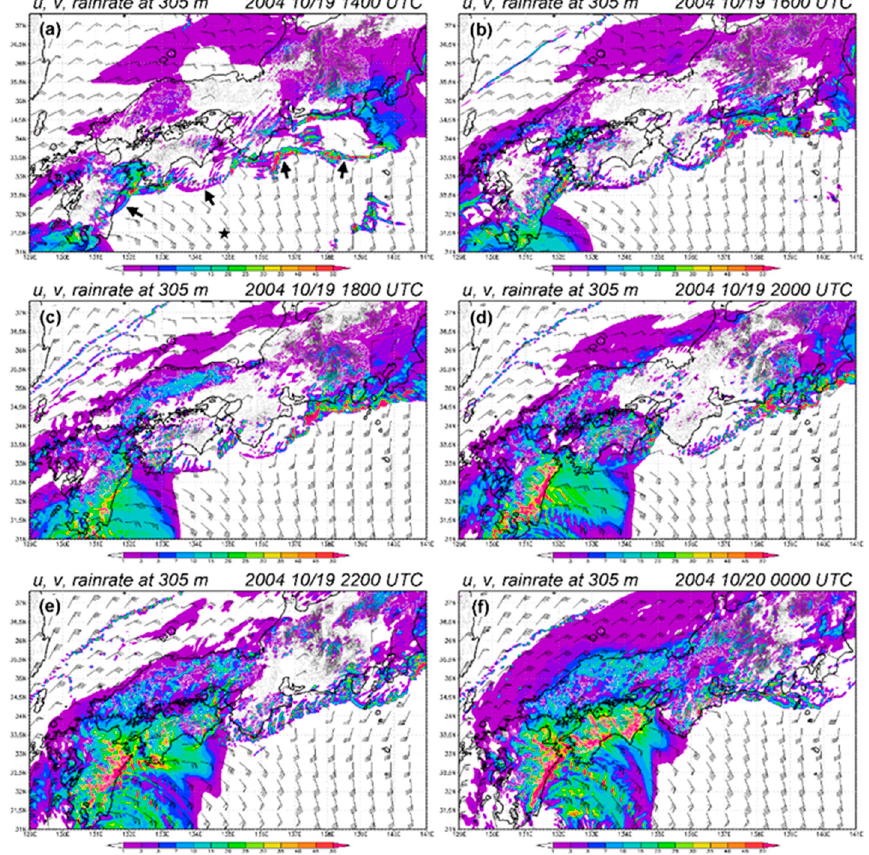
Figure 6. The model simulation of rainfall rate (mm h − 1 , shading, scale shown at bottom) and horizontal wind field (kt; pennants, full barbs, and half barbs represent 50 kts, 10 kts, and 5 kts, respectively) at 305 m every 2 h from ( a ) 1400 UTC 19 to ( f ) 0000 UTC 20 October 2004. The height contours at 305 m are drawn as thin, gray lines. In ( a ), the black arrows mark the arc-shaped rainbands in the simulation and the asterisk (at 31.5 °N, 134.875 °E) depicts the sounding location shown in Figure 7.